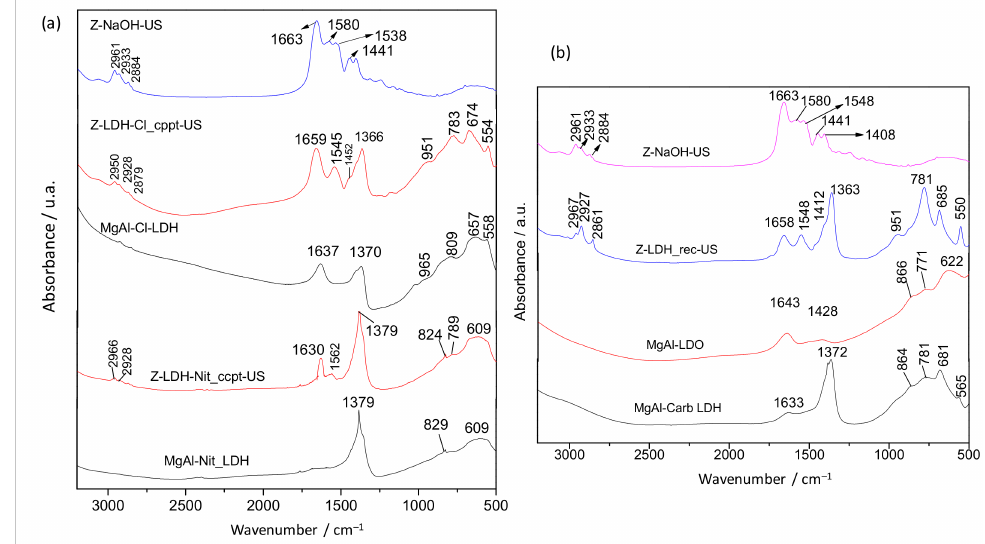
Figure 5. FTIR spectra in the 3200–500 cm − 1 region of LDH and Z-LDH biohybrids prepared by ( a ) co-precipitation and ( b ) reconstruction from zein dissolved in 0.1 M NaOH under US.